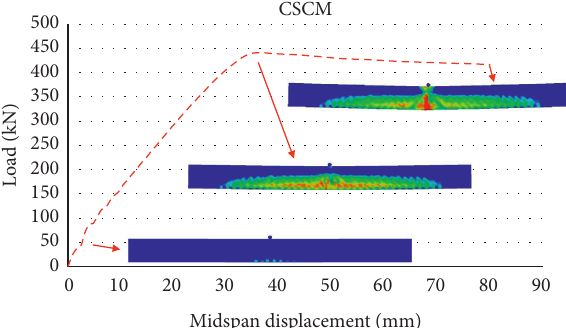
Figure 16: Effective plastic strains at different loading stages using CSCM concrete material option.